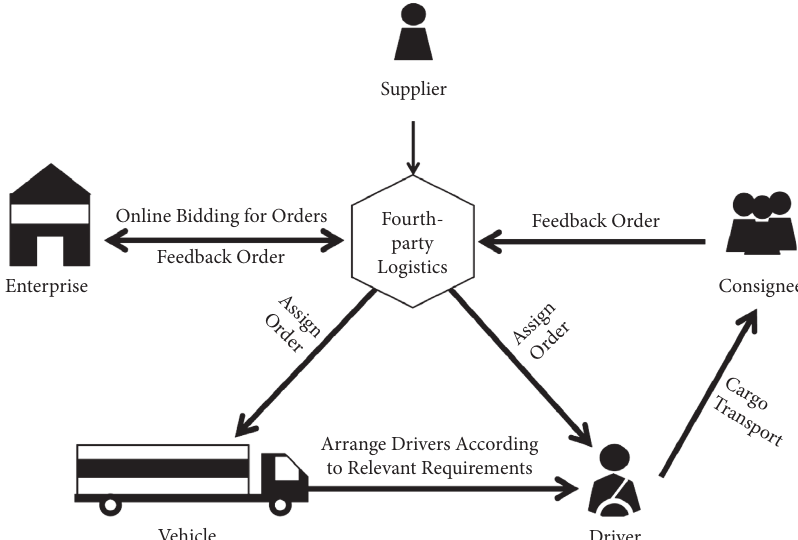
Figure 1: Bulk cargo fourth-party logistics network design.